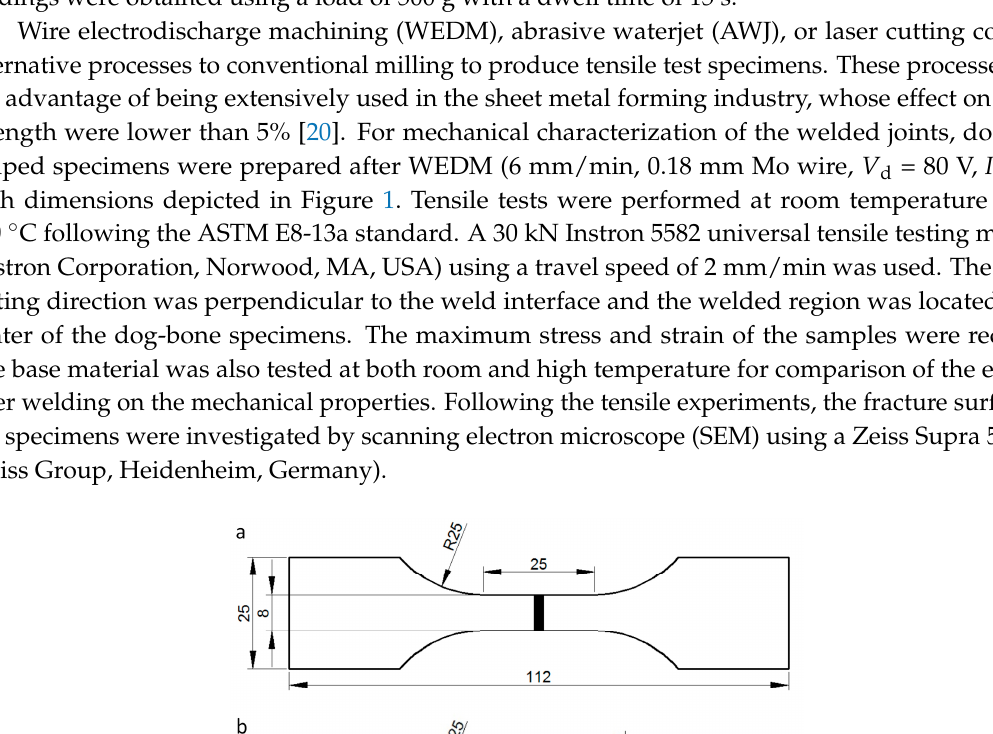
Table 2. Laser welding parameters used to join the BTi-6431S titanium alloy.